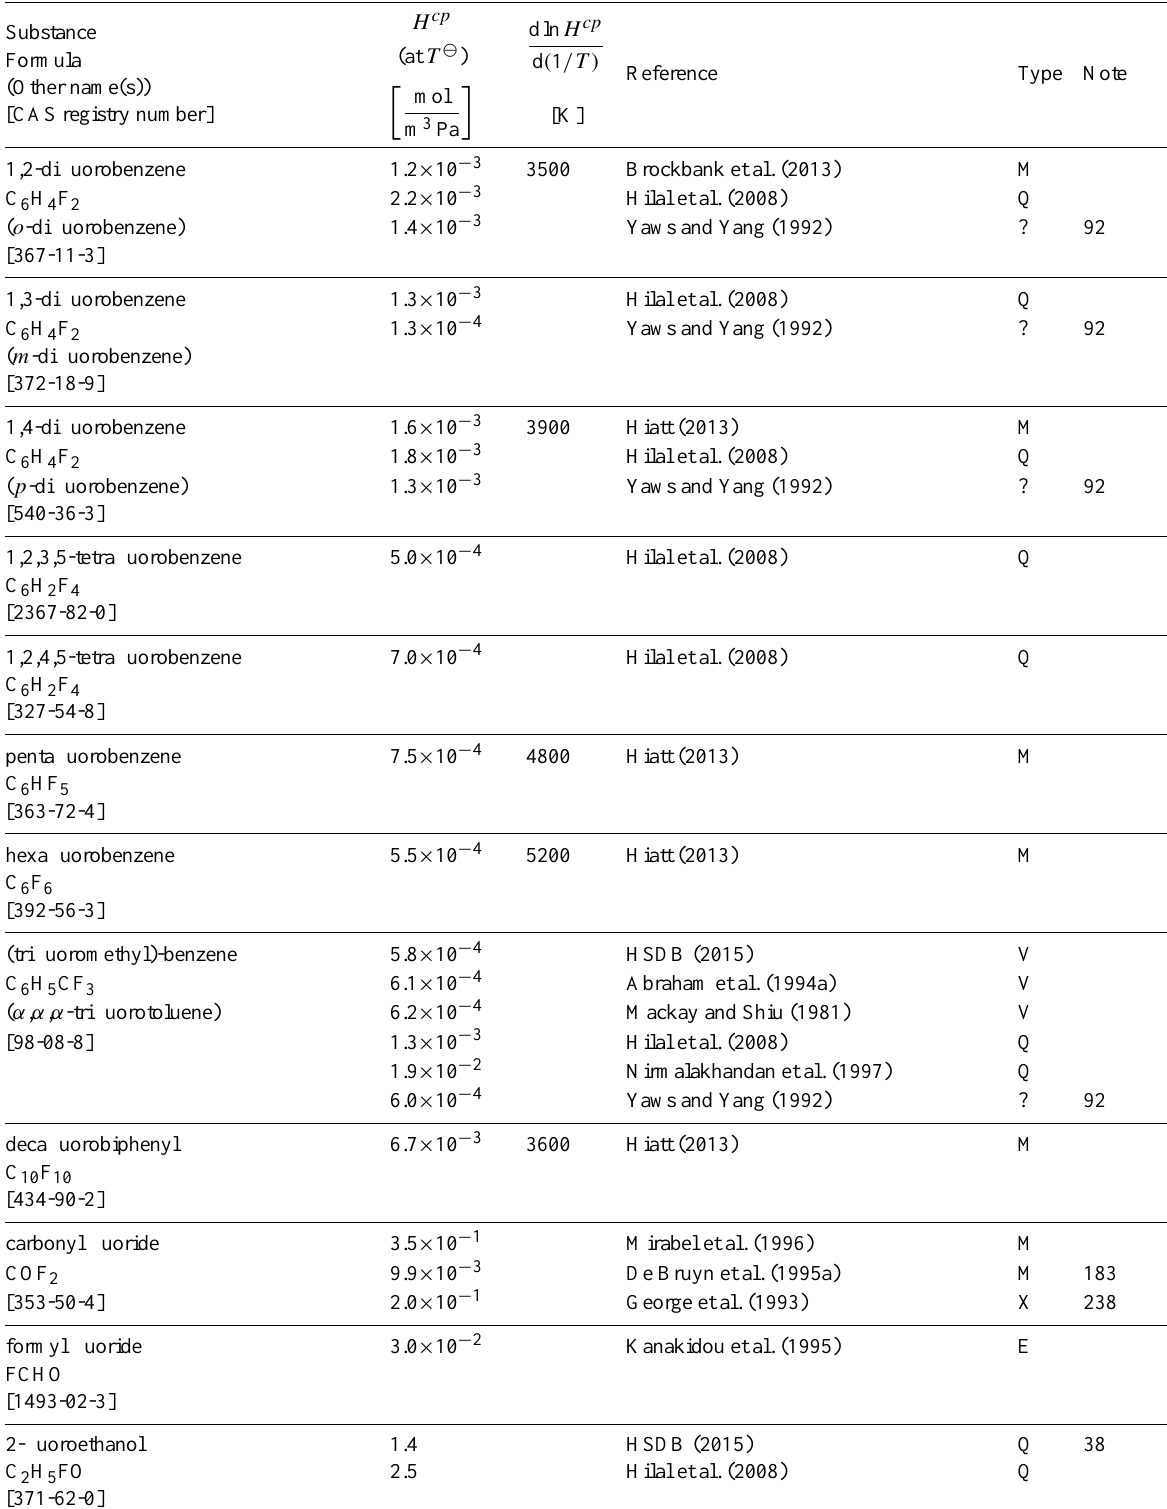
Table 6: Henry’s law constants for water as solvent